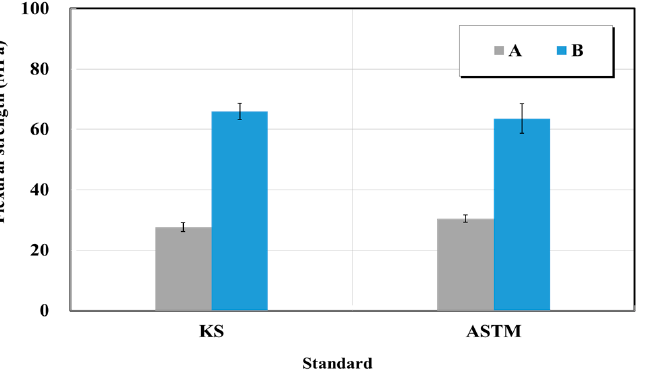
Figure 17. Flexural strength test result of crack-injection materials (epoxy resin) based on the KS and ASTM standards.